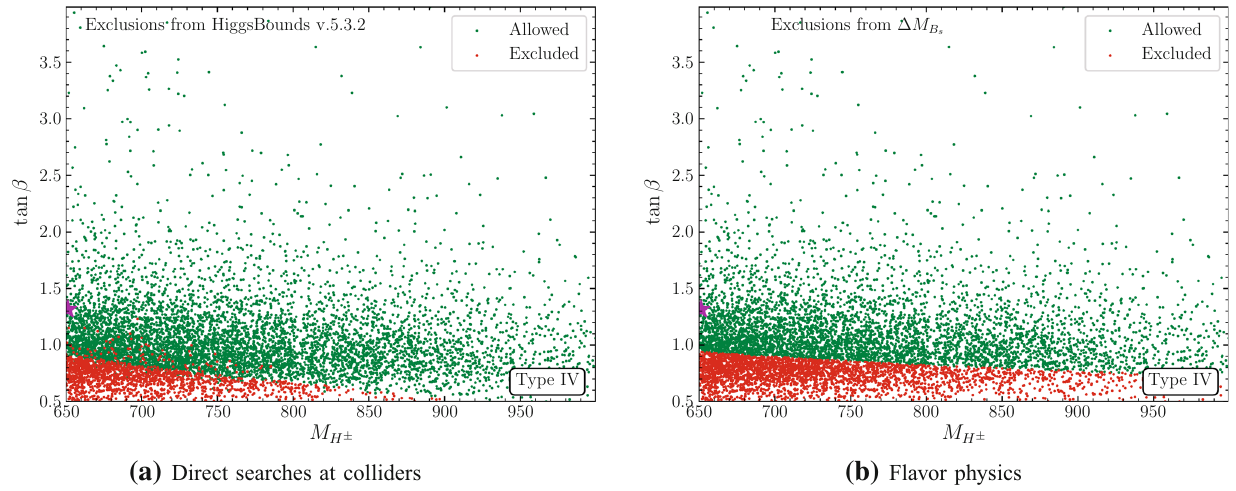
(b) Flavor physics